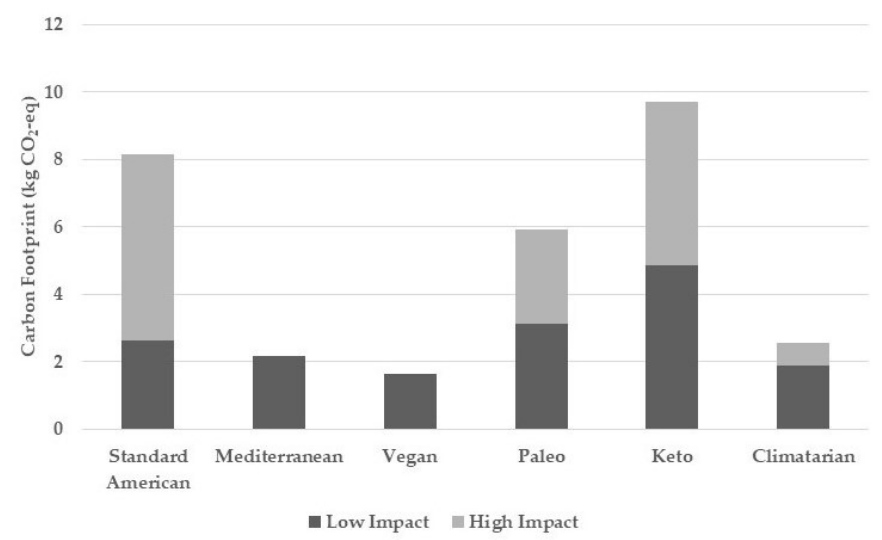
Figure 1. Estimated carbon-footprint values for U.S. diets, standardized to 2000 calories a day.